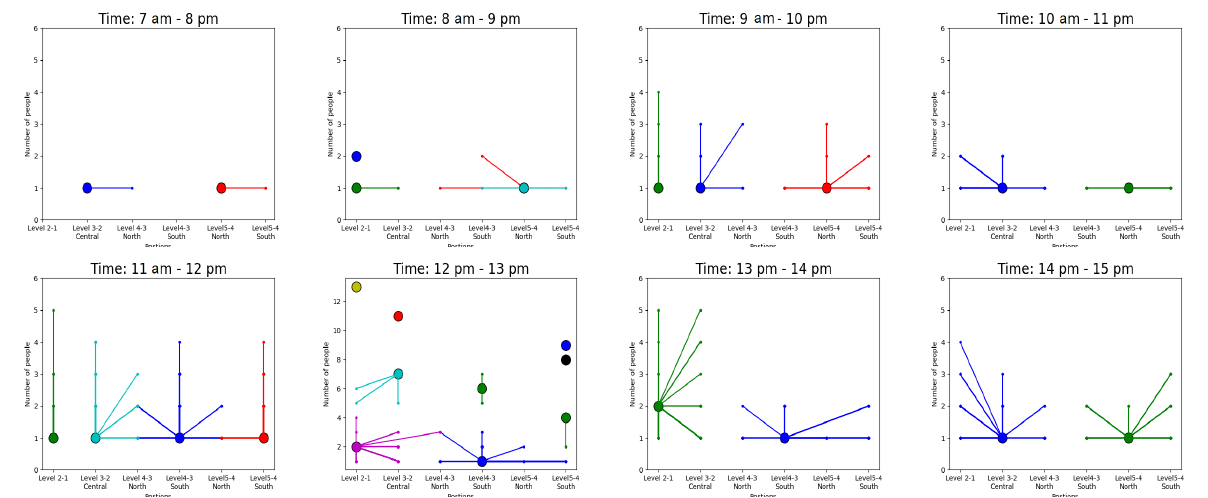
Figure 4: The evolution of micro-clusters